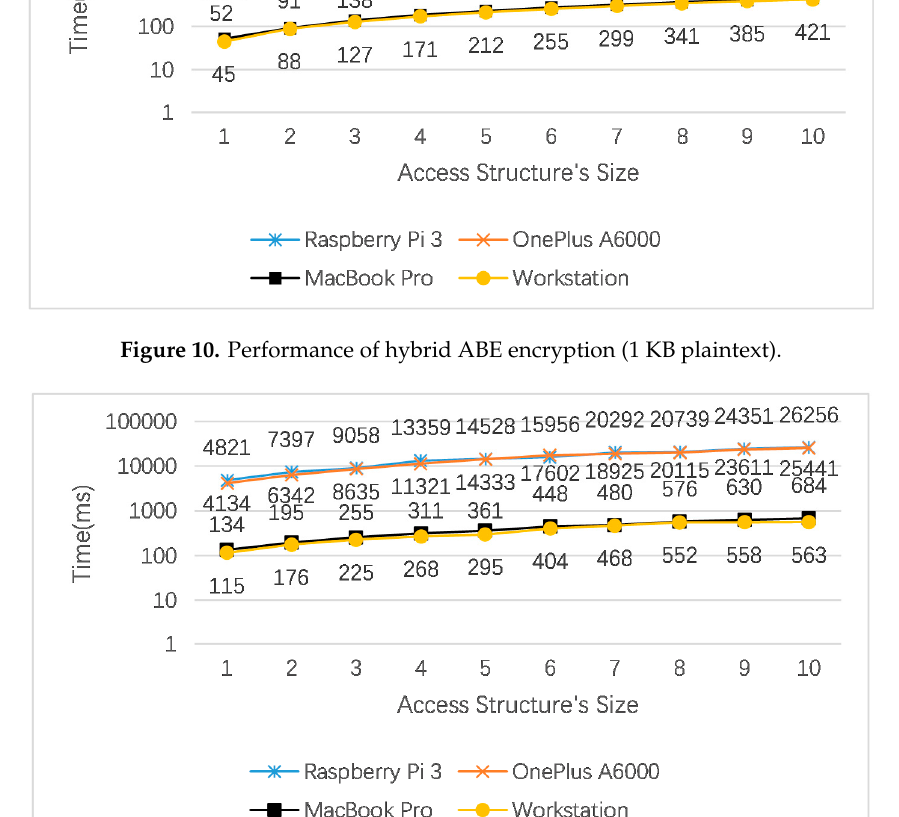
Figure 13. Hybrid ABE’s ciphertext’s size with respect to plaintext’s length (the size of access structure is 10). 5.3. Energy Consumption Evaluation We have also evaluated the energy consumption of the hybrid ABE scheme on a Raspberry Pi 3 and a OnePlus A6000 smartphone. Figure 14 shows the power consumption (mAh).